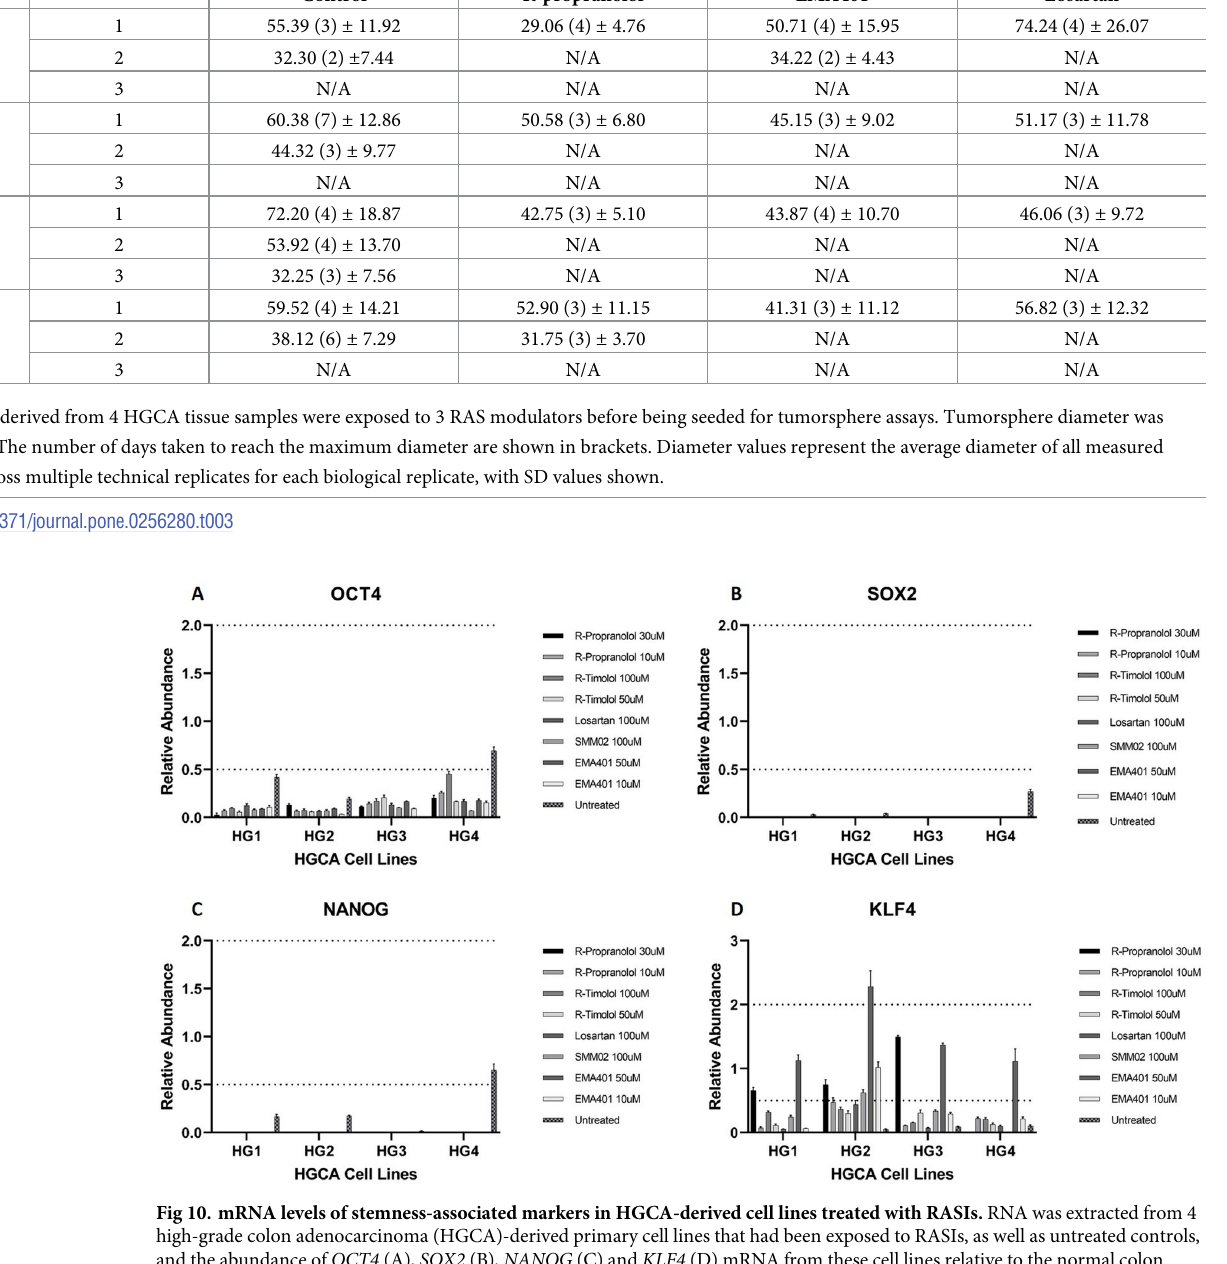
Table 3. Analysis of tumorsphere formation from treated cells. Sample